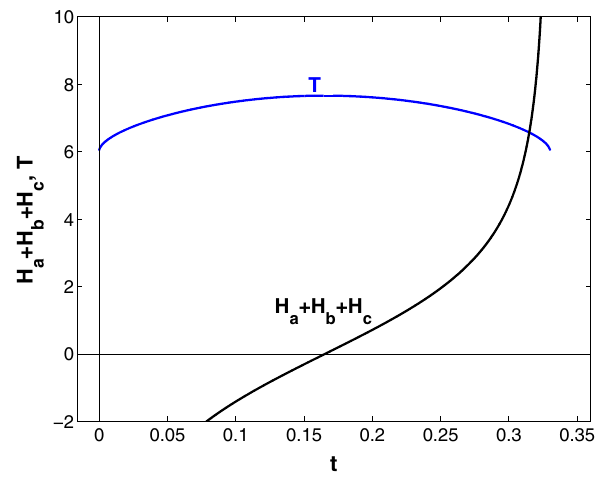
Fig. 5 The evolution of the torsion scalar T and sum of Hubble param- eters X = H a + H b + H c for N = 2, f 0 = − 1 initial values are H a ( 0 ) = 24 . 7, H b ( 0 ) = − 44 . 41, H c ( 0 ) = − 55 .